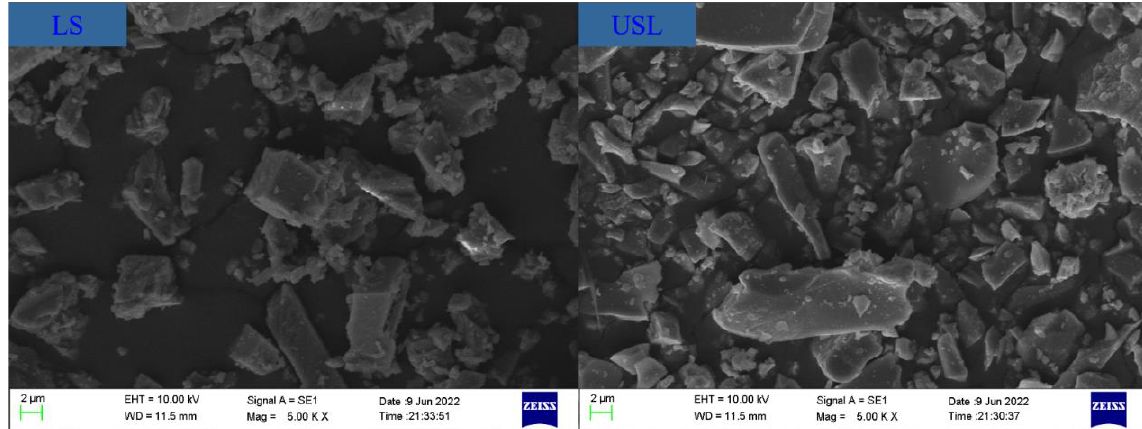
Figure 3. SEM pictures of USL and LS.